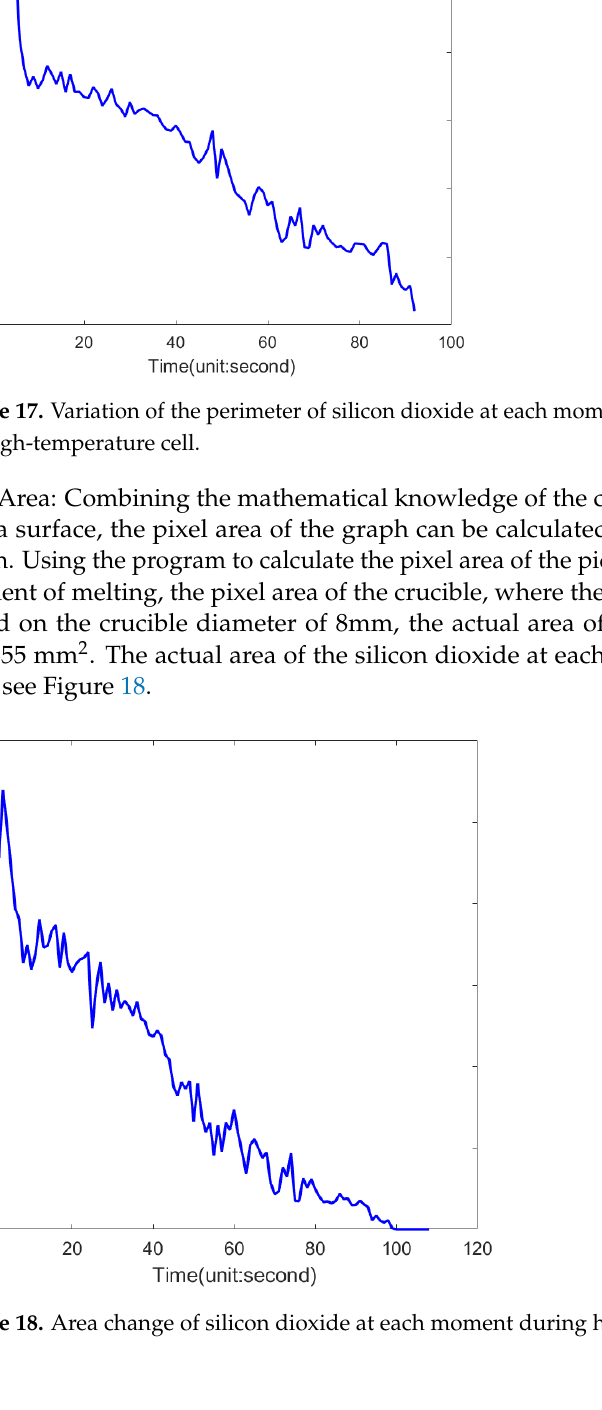
Figure 16. Graph of the change in mass rate of silicon dioxide at each moment during the melting process in the temperature cell.